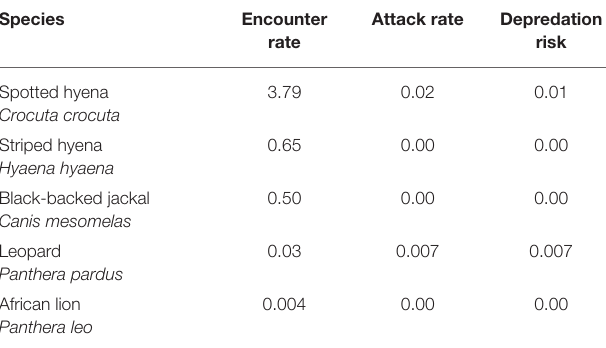
TABLE 3 | The average encounter rate, attack rate, and depredation risk at 12 bomas in Central Kenya from September, 2018 to May,